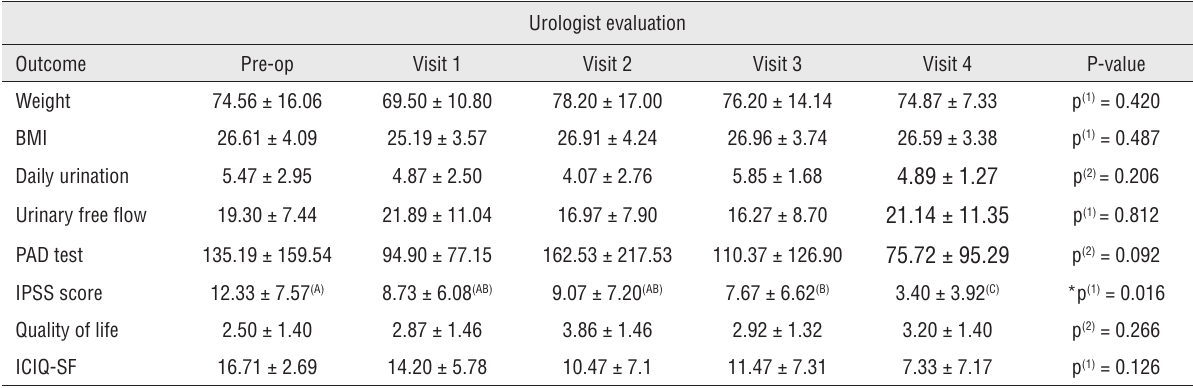
Table 3 - Statistics related to the different clinical and urological variables.